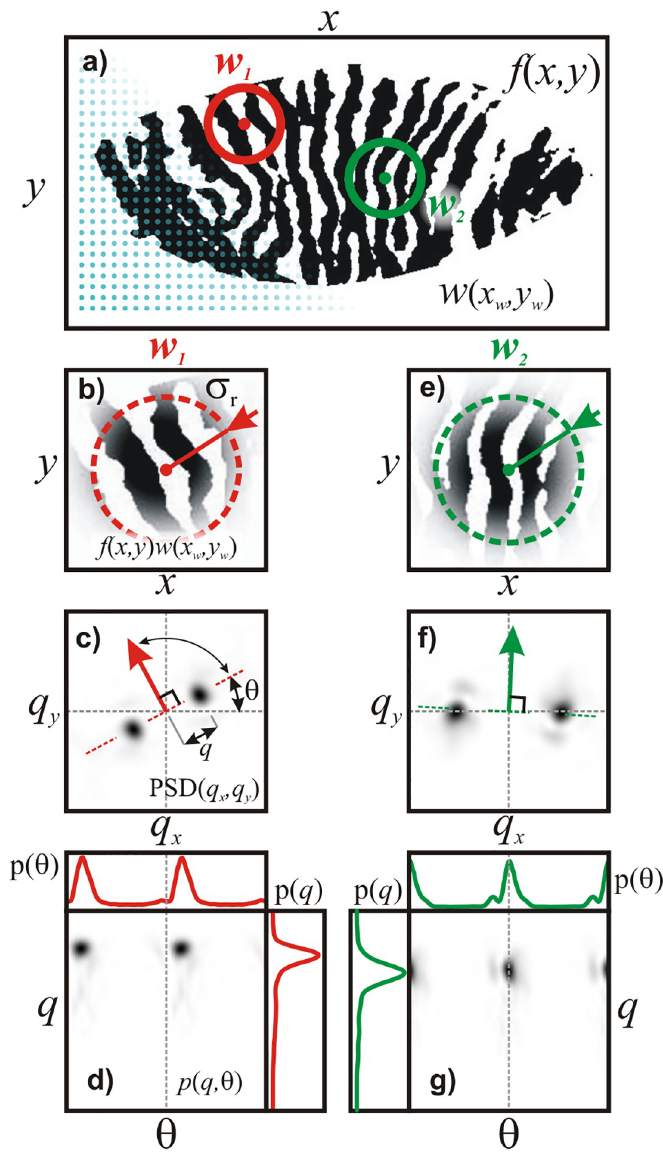
Fig 3. 2D Short-Time Fourier Transform (STFT) used for determination of local probability density for gland frequency, p ( q ) and orientation, p ( θ ). Panel a) shows original (binarized) Meibomian gland image, f ( x , y ). During the STFT analysis of an image, the Gaussian window is placed in strictly defined positions ( x w , y w ), which are illustrated a grid of blue dots. Two arbitrary positions of the window, w 1 and w 2 , are presented as a red and a green circle, respectively. Panels b) and e) shows a Meibomian image limited by windows w 1 and w 2 , respectively. The radius of the dashed circles show the width (variance) of the Gaussian window, σ r . The image limited by w 1 shows broader and more inclined gland structure then that seen in w 2 . Panels c) and f) shows PSD in Cartesian coordinates calculated for images limited by windows w 1 and w 2 , respectively. The dark spots are the spectral features whose radial distance, q , informs about gland pattern spatial frequency, whereas the angular distance, θ , corresponds to the gland orientation. The thick colored arrow (pointing at θ +90˚ direction) indicates the mean gland orientation. Notice how it complies with the real structure shown in panels b) and e). Panels d) and g) show PSD in polar coordinates calculated for images limited by windows w 1 and w 2 , respectively. In this representation PSD corresponds to a probability map of finding a gland structure with a given frequency, q , and orientation, θ . Marginal plots show local probability distributions p ( q ) and p ( θ ) which were obtained by projection of p ( q , θ ) on the appropriate axis (S2